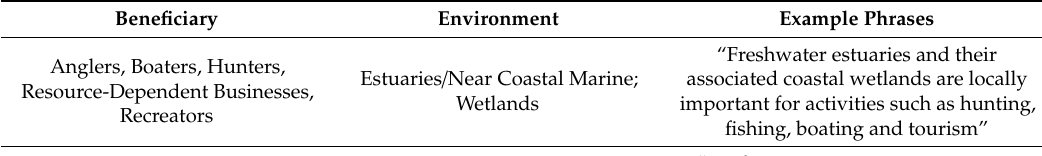
Table 7. Example phrases from the Lake Superior National Estuarine Research Reserve